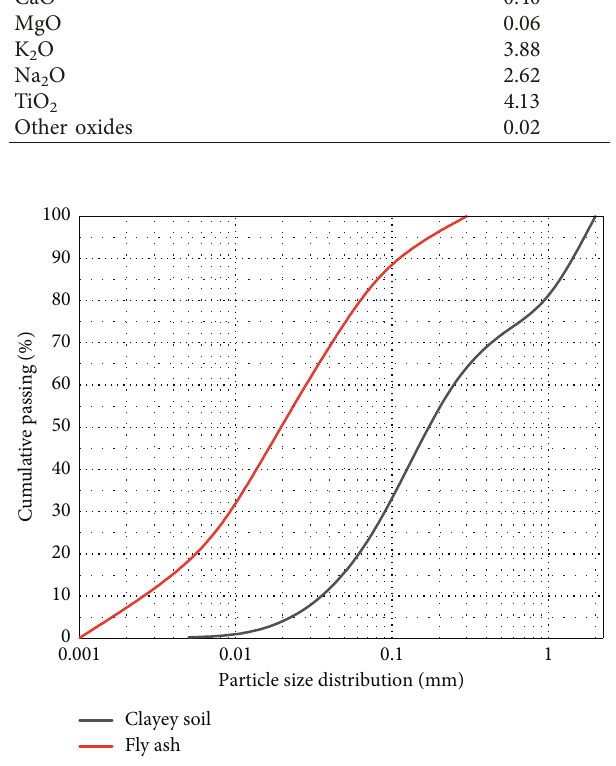
Figure 1: Particle size distribution of clayey soil and fly